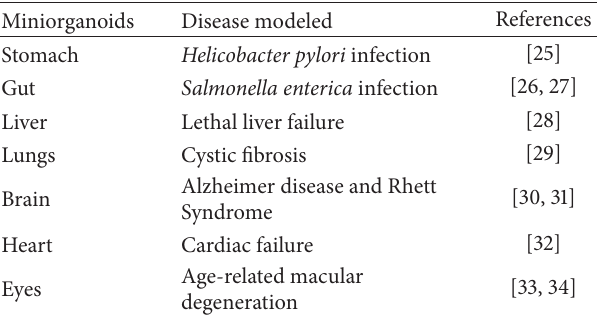
Table 1: Miniorganoids that have been obtained from iPSCs and associated disease